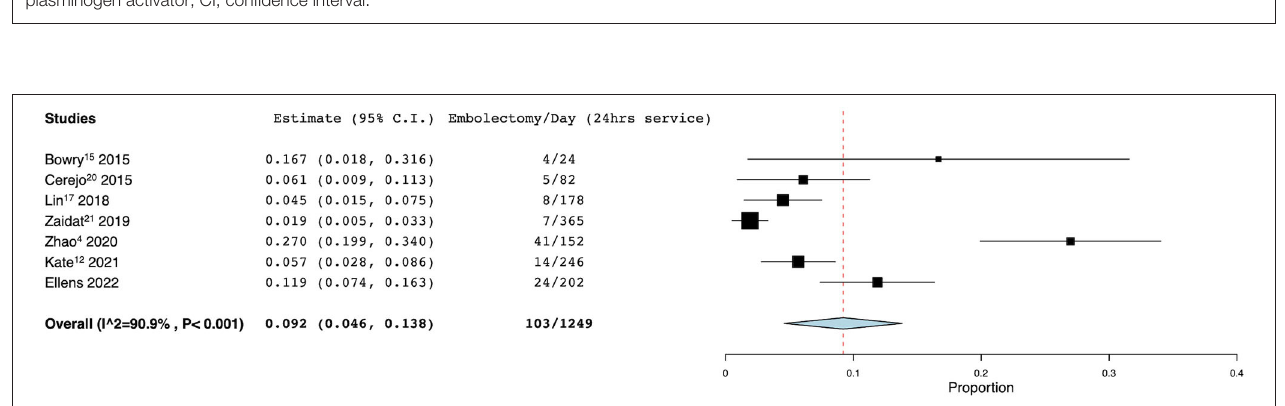
FIGURE 4 | Rate of mechanical thrombectomy per day. Forest plot demonstrating the results from the meta-analysis of the rate of mechanical thrombectomy per day. CI, confidence